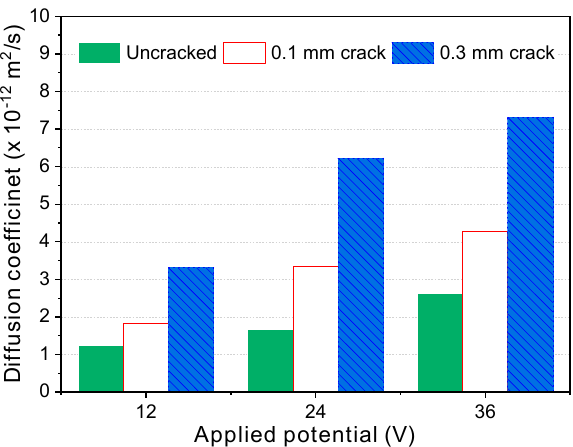
Figure 6. Diffusion coefficients according to the applied potential and crack width.